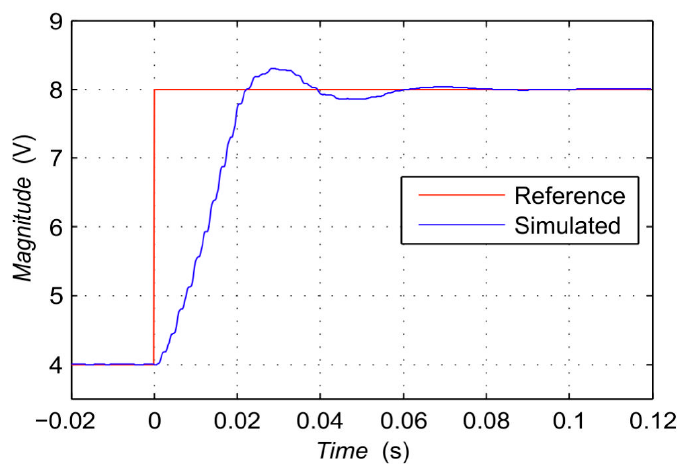
Figure 4. Voltage 5th harmonic magnitude response to step reference.